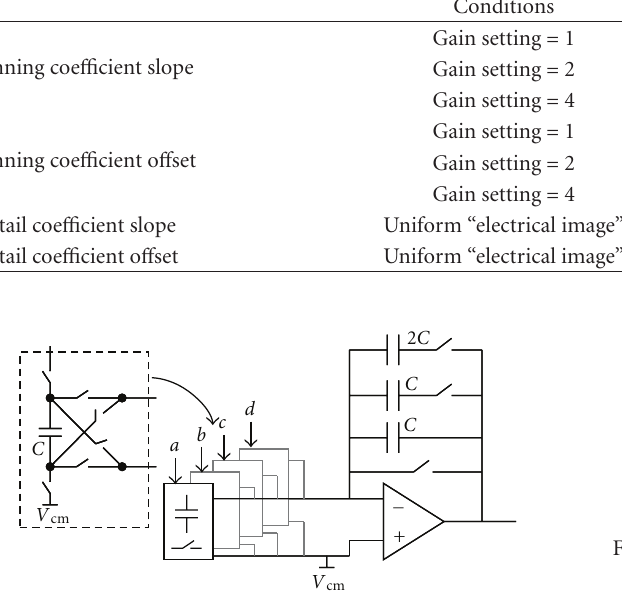
Figure 7: Analog DWT and gain stage implementation.